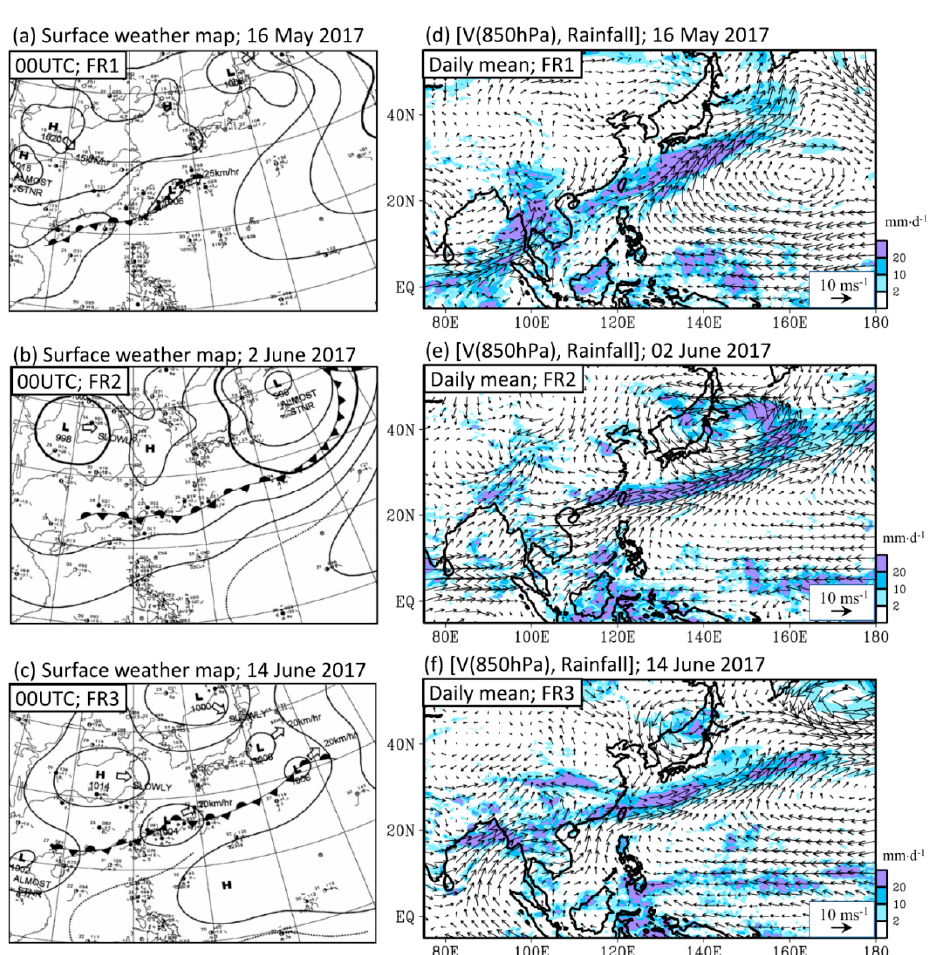
Figure 2. Surface weather maps for the selected date of ( a ) FR1: 16 May 2017, ( b ) FR2: 02 June 2017, and ( c ) FR3: 14 June 2017. ( d )-( e )-( f ) is the daily mean of low-level wind circulation at 850 hPa superimposed with the daily rainfall amount related to ( a )-( b )-( c ), respectively.